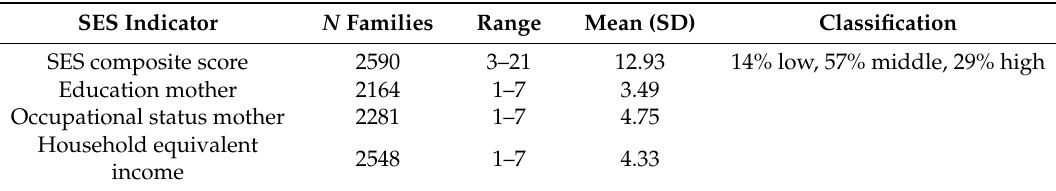
Table 2. Socio-economic status (SES) in the LIFE Child study.